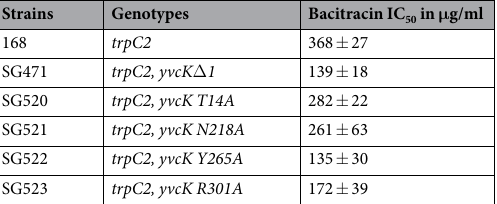
Table 1. Effect of yvcK point mutations on antibiotic resistance. Bacitracin resistance of WT strain (168) and Δ yvcK strain (SG471) used as controls and of strains producing YvcK-T14A (SG520), YvcK-N218A